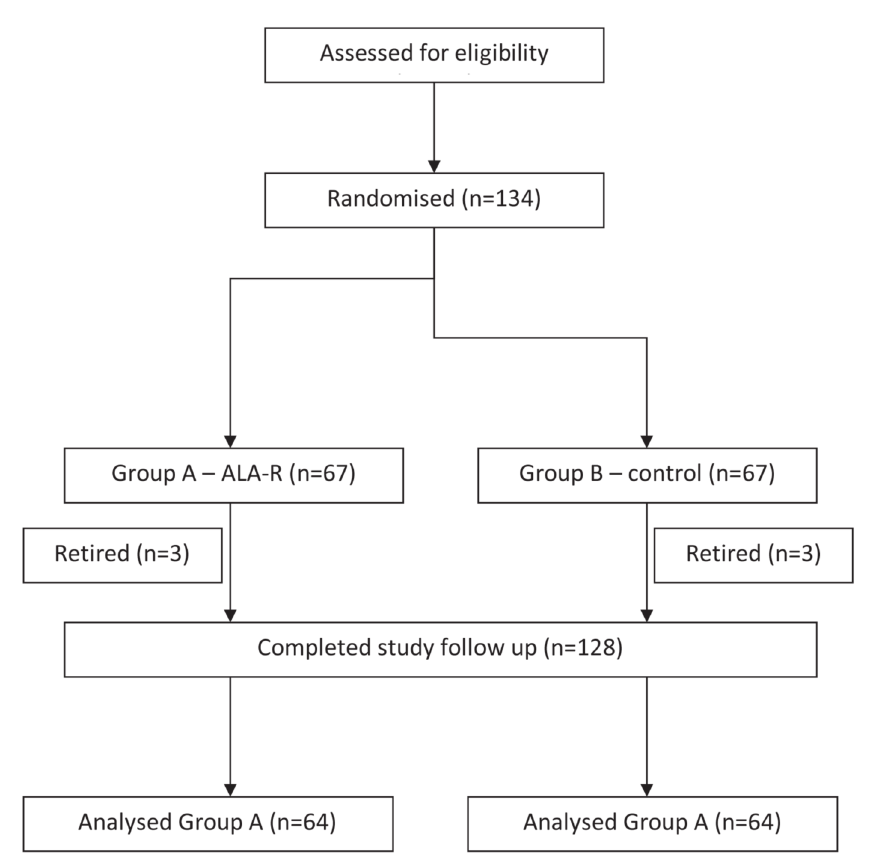
Study flow Fig. 1: